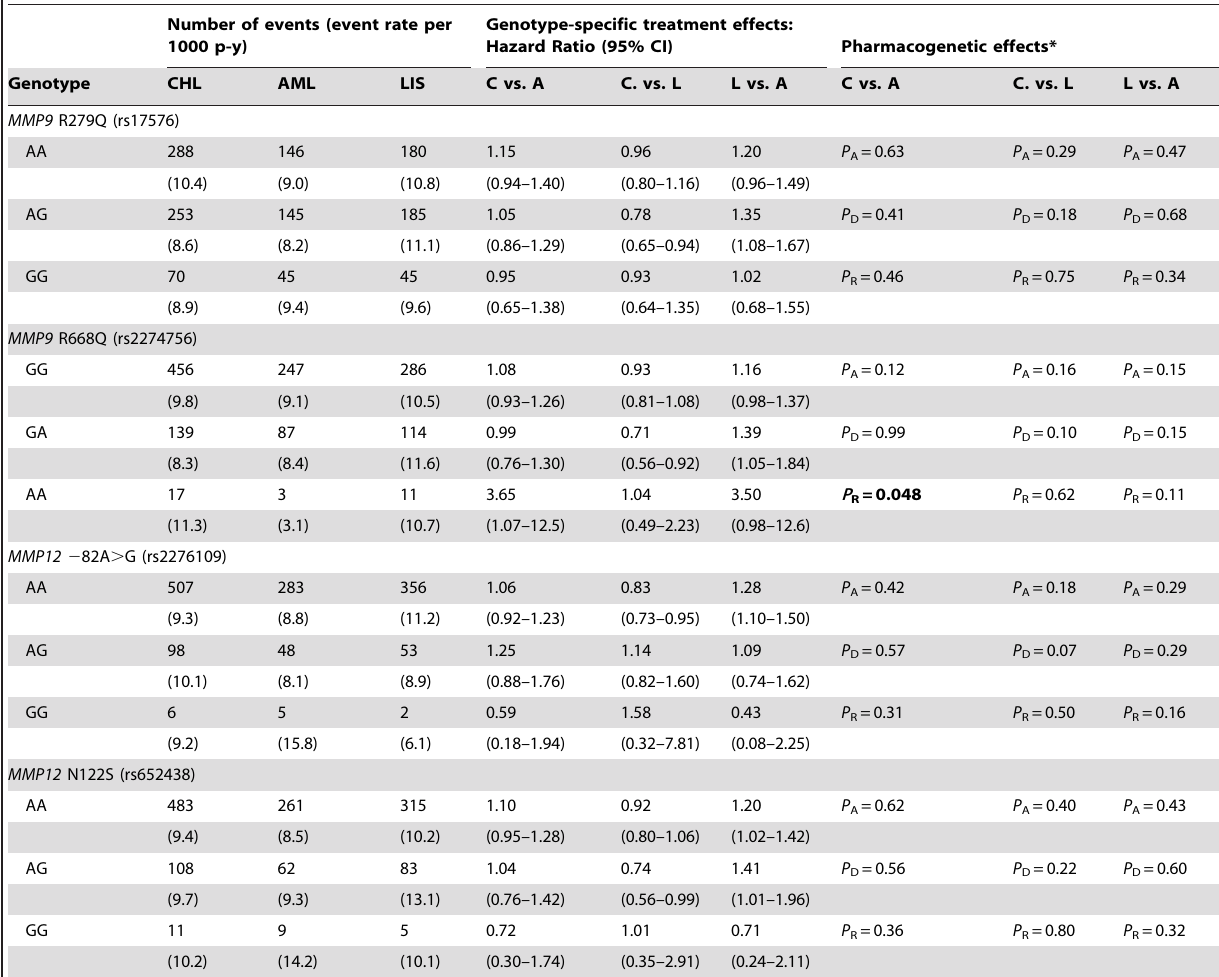
Table 7. Pharmacogenetic effects of MMP genetic variants on stroke.